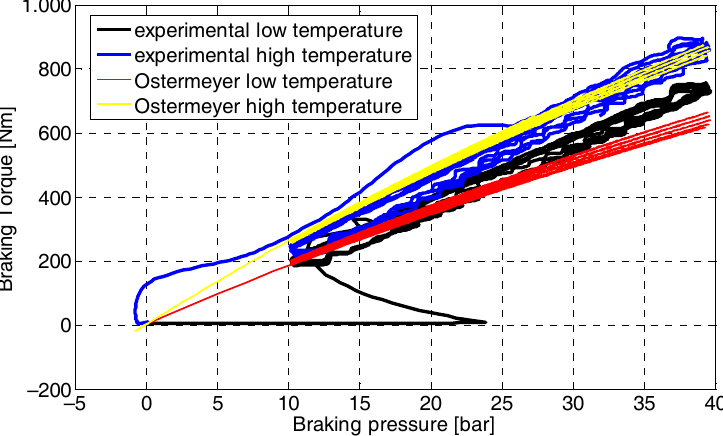
Figure 6. The measurements of the first dataset show a memory effect (hysteresis) of BLCF against the braking pressure and a clear dependence of the resulting braking torque on rising temperature. The model is capable of capturing the temperature dependence but not the frictional lag against the pressure.